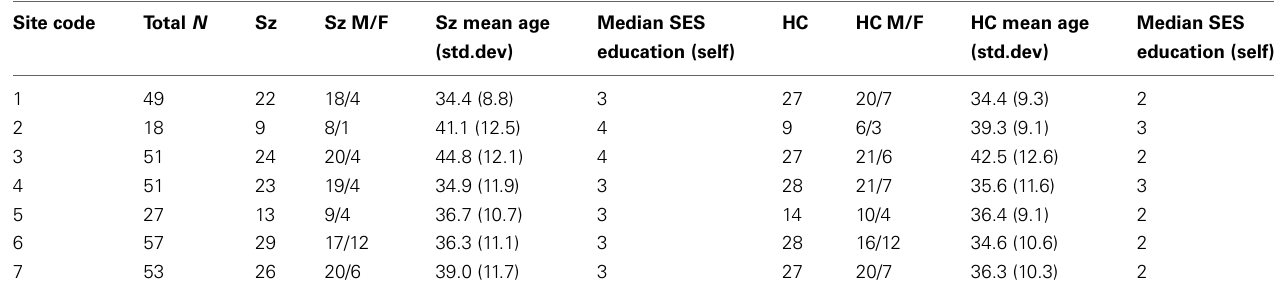
Table 1 | Subject numbers, gender, age, and median education by data collection site. Site code